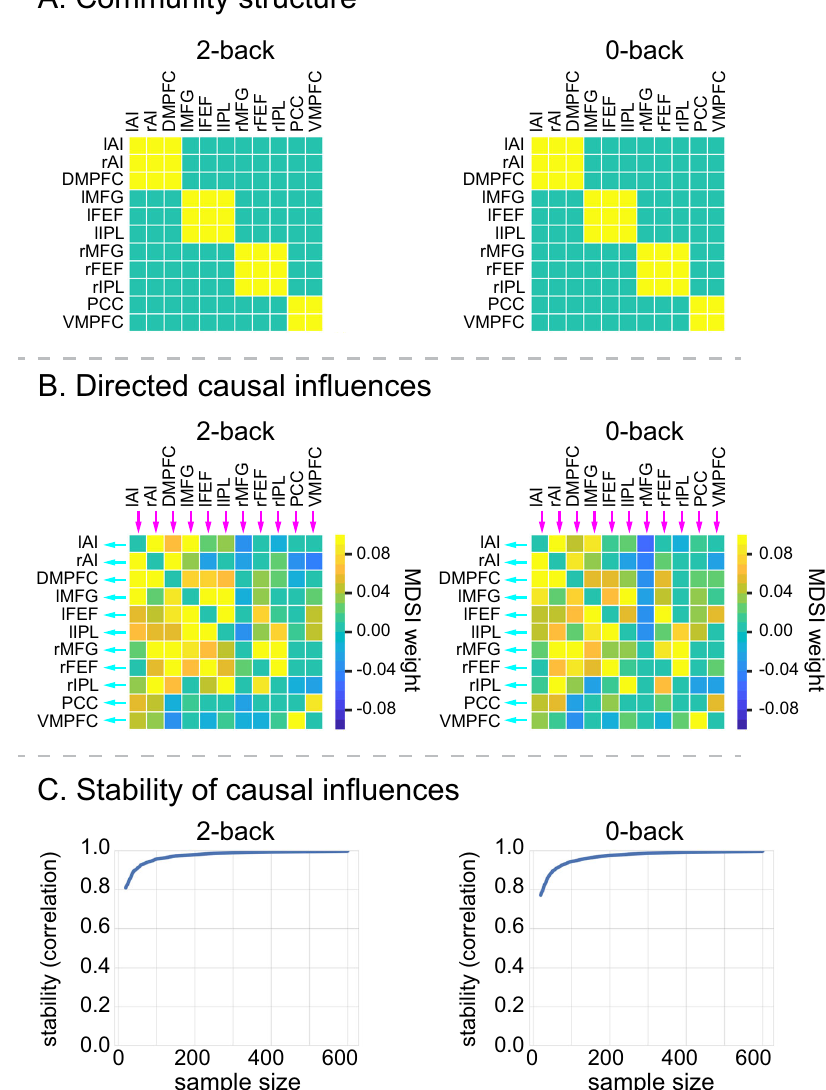
Fig. 2 Working-memory load-speci fi c dynamic causal in fl uences. A MDSI and graph-theoretic analyses identi fi ed four communities associated with directed causal in fl uences in both the 2-back and 0-back working-memory task conditions: (i) SN consisting of lAI, rAI, and DMPFC nodes, (ii) left FPN consisting of lMFG, lFEF, and lIPL nodes, (iii) right FPN consisting of rMFG, rFEF and rIPL nodes, and (iv) DMN consisting of PCC and VMPFC nodes ( p < 0.01, FDR-corrected, two-sided t -test). N = 737 participants. Yellow cells indicate that a pair of ROIs are grouped into the same community and cyan cells indicate that a pair of ROIs belong to different communities. B Signi fi cant directed causal in fl uences between SN, FPN, and DMN ROIs in the 2-back and 0-back working-memory task conditions ( p < 0.01, FDR-corrected, two-sided t -test). N = 737 participants. Red cells indicate signi fi cant positive in fl uences and blue indicates signi fi cant negative in fl uences. C Stability analyses revealed highly stable multivariate patterns of causal in fl uences among SN, FPN, and DMN nodes in 2-back and 0-back task conditions ( r > 0.8 for sample size >25). X -axis shows sample sizes ranging from 20 to 600. Y -axis shows stability, computed as the correlation of multivariate causal in fl uence patterns between the original sample and random subsamples drawn from N = 737 participants. lAI left anterior insula, rAI right anterior insula, DMPFC dorsomedial prefrontal cortex, lMFG left middle frontal gyrus, rMFG right middle frontal gyrus, lFEF left frontal eye fi eld, rFEF right frontal eye fi eld, lIPL left intraparietal lobule, rIPL right intraparietal lobule, PCC posterior cingulate cortex, VMPFC ventromedial prefrontal cortex. Source data are provided as a Source data fi signaling hubs during performance of the two working-memory paired t -test). Stability analysis revealed that this rAI fi nding was tasks. To accomplish this, we computed the out fl ow degree of highly stable (>80%) with sample sizes of N = 100 or more each node in each task and participant. The out fl ow degree is the (Fig. 3B). That is, the rAI showed the consistently highest out fl ow, weighted node degree: averaged out fl ow weights (all the output across multiple random subsamples of the data. connections from a node to all other nodes) minus averaged In contrast, the rMFG and rFEF showed signi fi cant in fl ow, in fl ow weights (all the input connections to a node from all other with the rMFG showing the highest in fl ow degree ( p < 0.05, FDR- nodes). The rAI and lAI showed signi fi cant positive out fl ow in corrected, Fig. 3A, two-side paired t -test). Stability analysis also both the 2-back and 0-back conditions, with the rAI showing the revealed that this rMFG fi nding was highly reliable (>80%) with highest out fl ow degree ( p < 0.05, FDR-corrected, Fig. 3A, two-side subsample sizes of N = 80 or more (Fig. 3B). That is, the rMFG